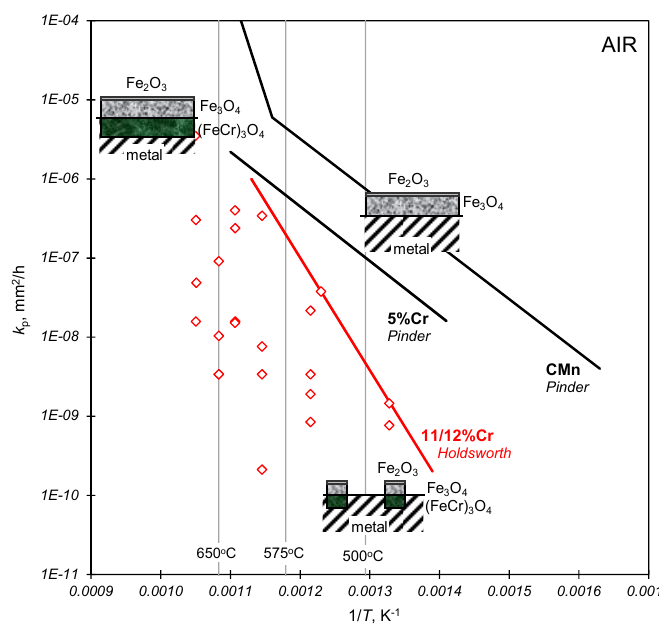
Figure 10. The influence of chromium content on oxidation kinetics for a range of power plant steels in air [23] (Insets indicate oxidation mechanisms for the low- and high-alloy steels) .